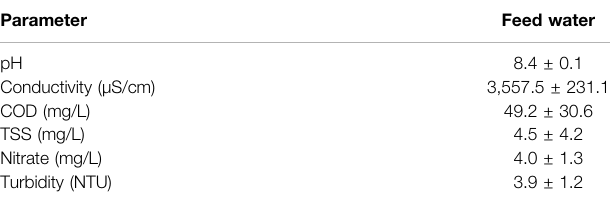
TABLE 1 | Brewery secondary ef fl uent wastewater physico-chemical and chemical